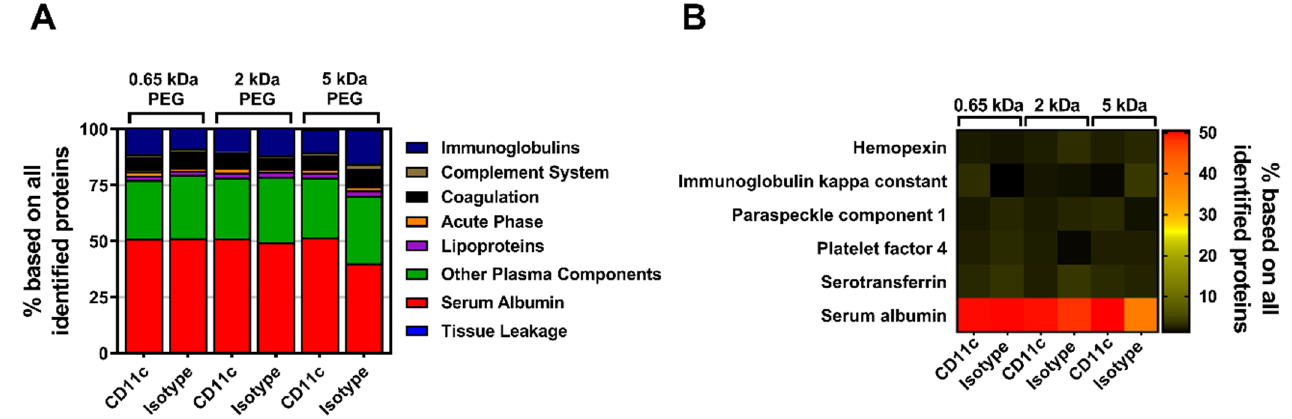
Figure 6. Antibody surface-modifications have no influence on the murine biomolecular protein corona composition. Adsorbed corona proteins were analyzed by LC-MS and either sorted into eight protein groups ( A ), or individually plotted as a heatmap ( B ).